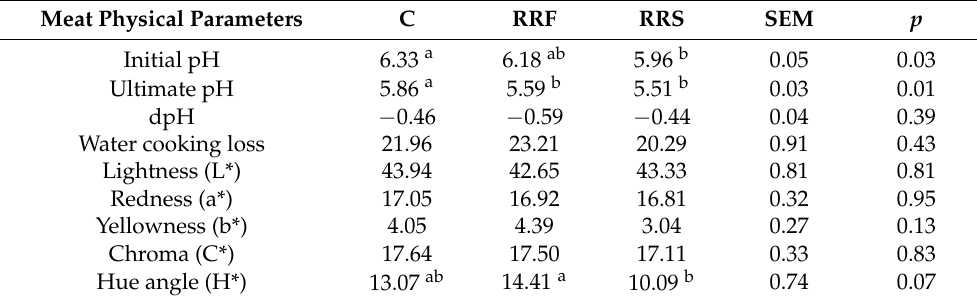
Table 4. Meat physical properties in Barbarine lambs fed RR-based concentrate.